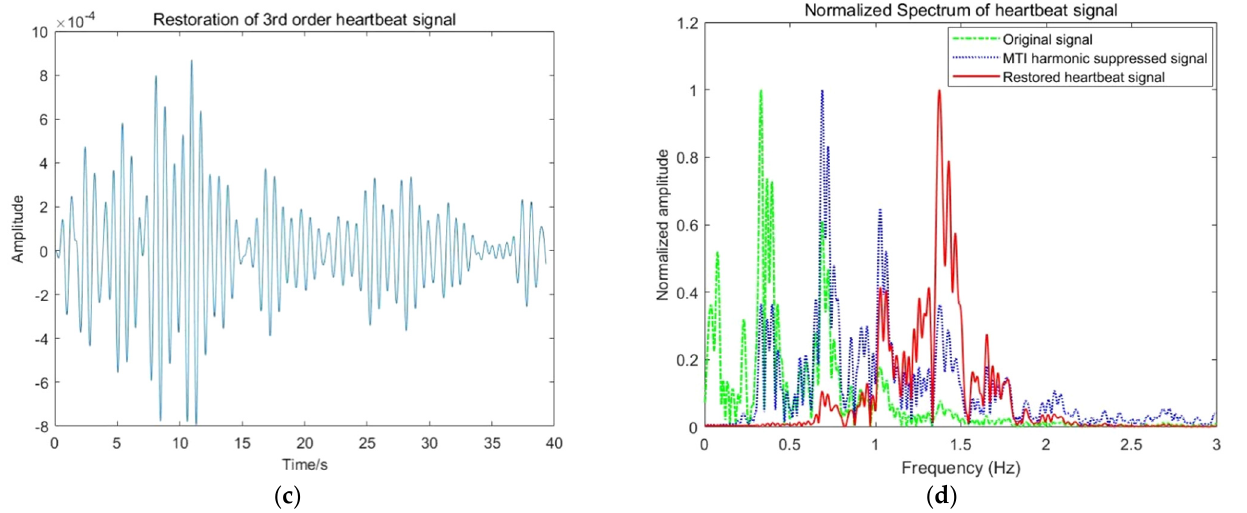
Figure 23. Heartbeat signal restoration result: ( a ) Original signal; ( b ) MTI harmonic suppressed signal; ( c ) Restored heartbeat signal; ( d ) Normalized spectrum.